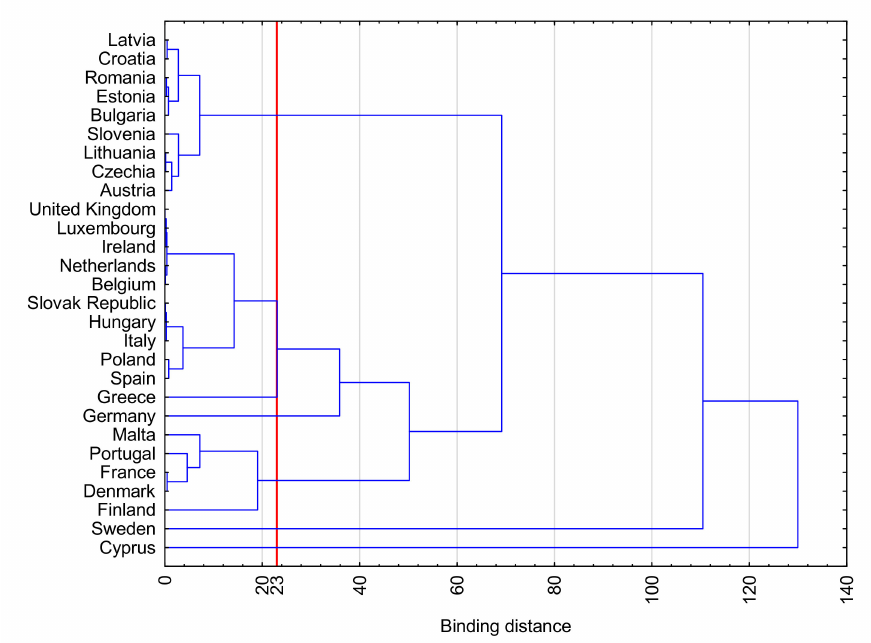
Figure 2. Results of the hierarchical grouping of similarities between the EU countries in final energy consumption from renewable energy sources in households’ sector in 2019 using the Ward’s method. Source: own elaboration based on data from